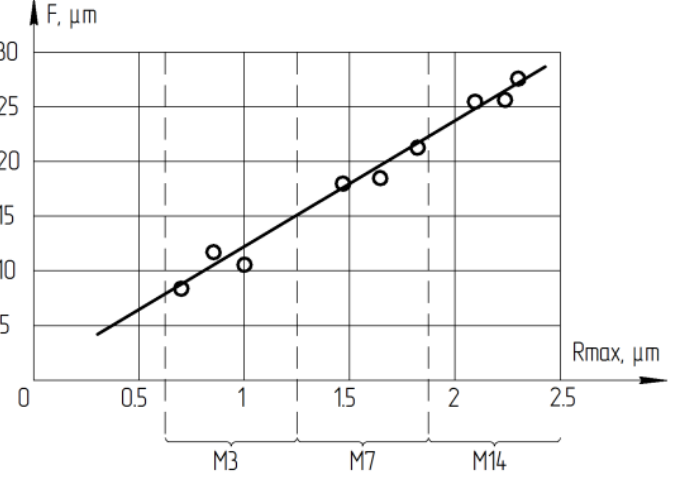
Figure 10. Dependence of the deformed layer depth on the height of the relief layer h (Rmax).